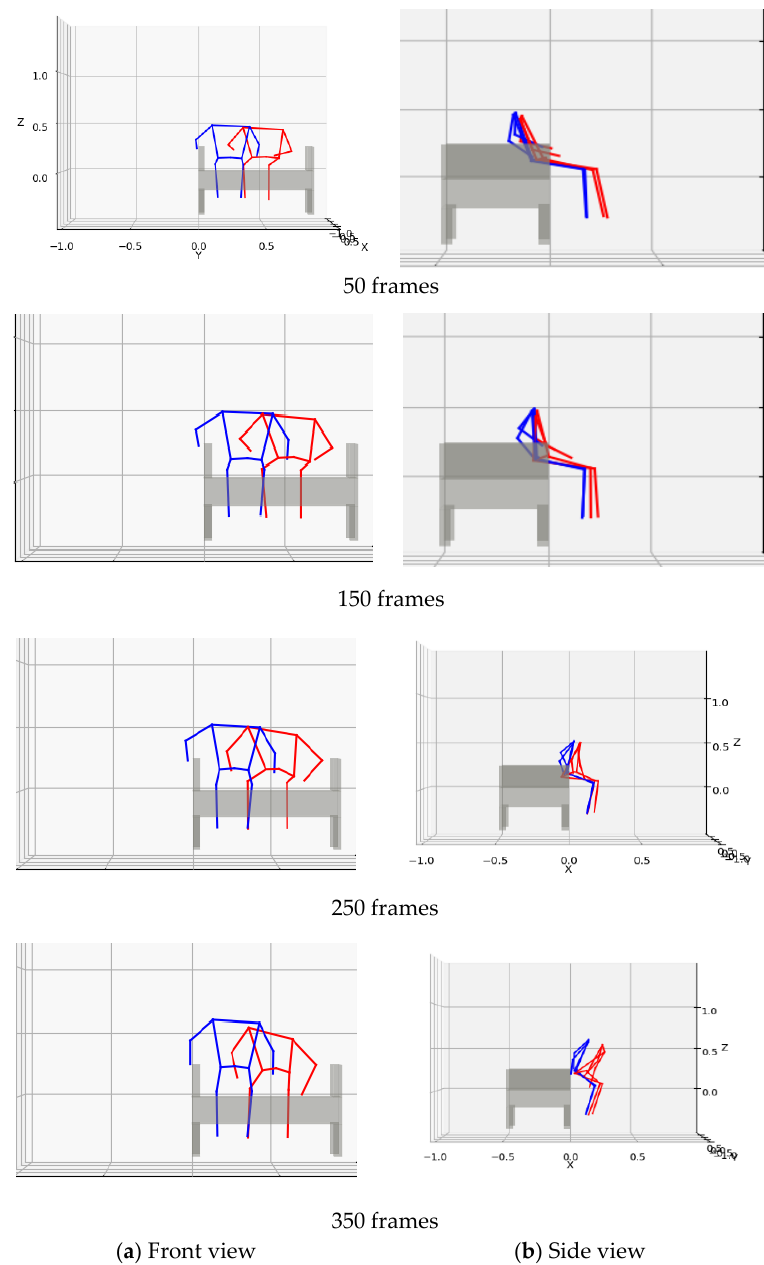
Figure 5. Clustering result of 24 standing behavior from chair, sofa, and nursing bed.